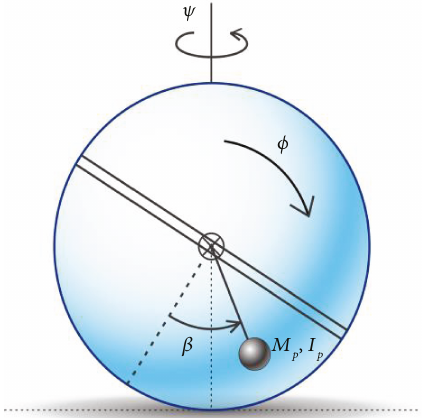
Figure 3: Reference frames and kinematic schemes of rotation around the longitudinal axis resulting in transverse motion of the